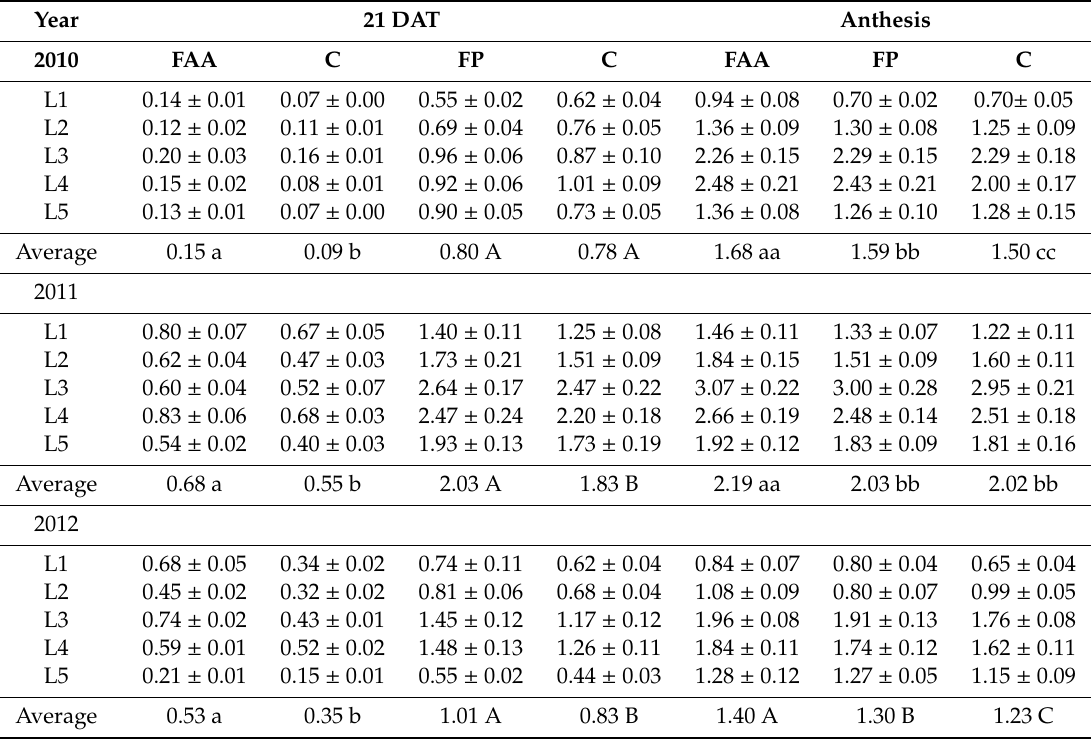
Table 7. E ff ects of applied fertilizers on maize leaf area index.